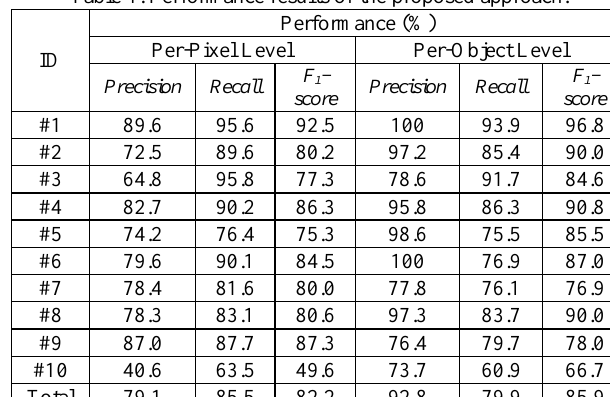
Table 1. Performance results of the proposed approach.